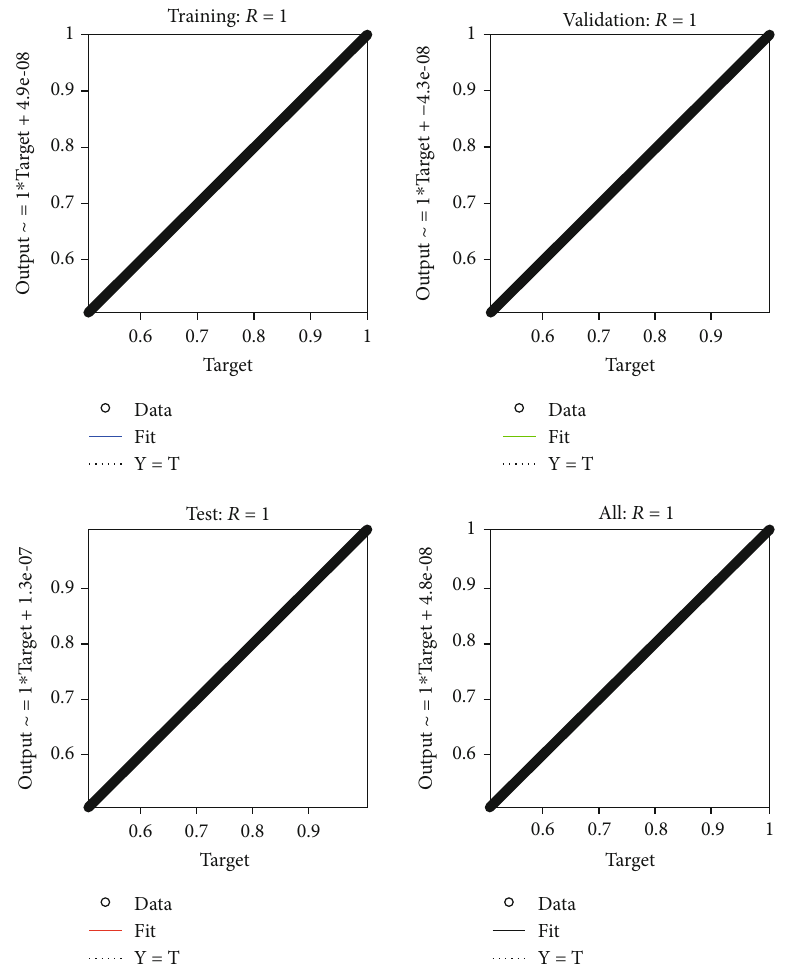
Figure 8: DNN-PV MPPT controller showing the best regression.